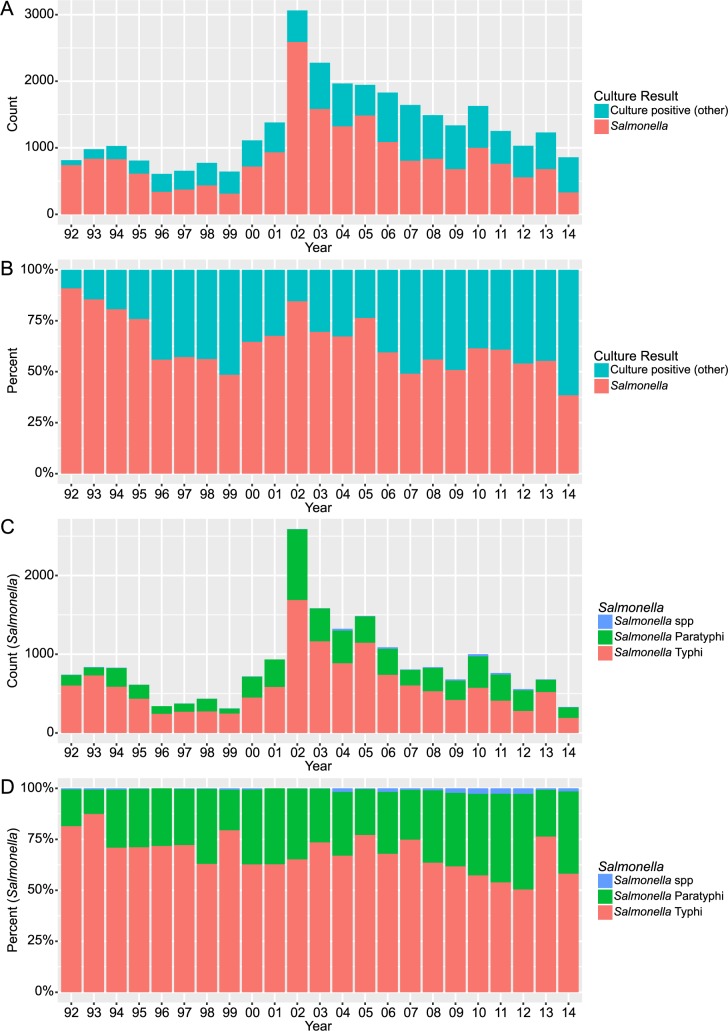
The annual distribution of bacteria positive blood cultures from 1992 to 2014. Bar graph showing the annual counts (A) and percentages (B) of Salmonella-positive cultures in all positive blood samples collected from 1992 to 2014. The annual counts and percentages of S. Typhi, S. Paratyphi, and Salmonella spp. in all Salmonella-positive cultures collected from 1992 to 2014 are shown in (C) and (D), respectively.